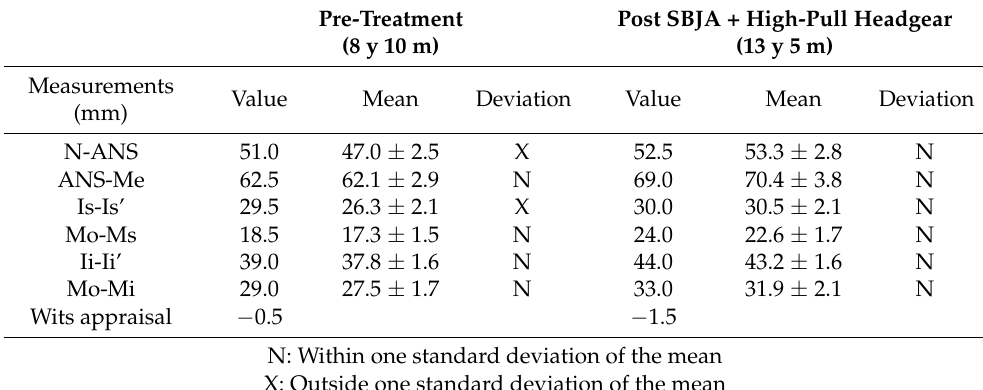
Table 6. Cephalogram distance measurements of Case 3.